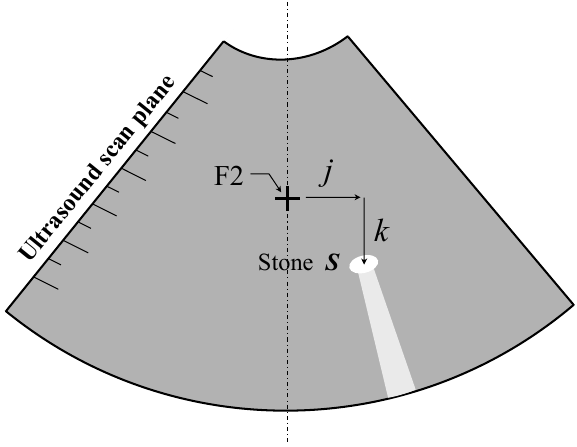
Figure 4. The schematic diagram of the stone deviation in the US